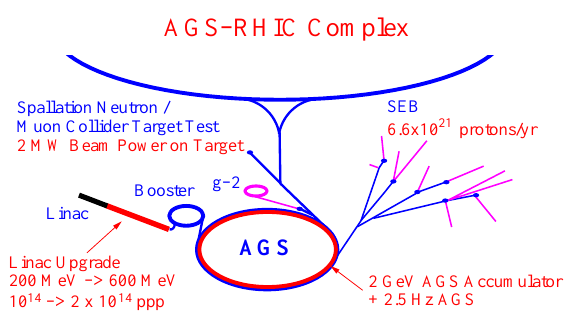
FIG. 13. (Color) The AGS–RHIC accelerator complex and a summary of possible intensity upgrades for the